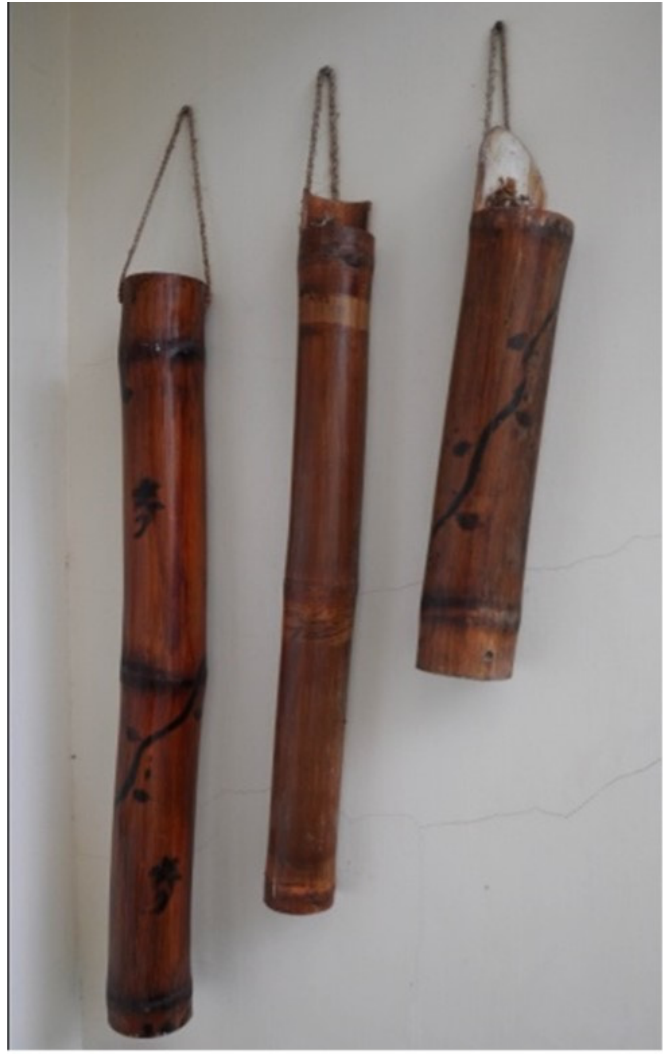
Figure 4. A sample of the bamboo raft used by families. Photo by the author.